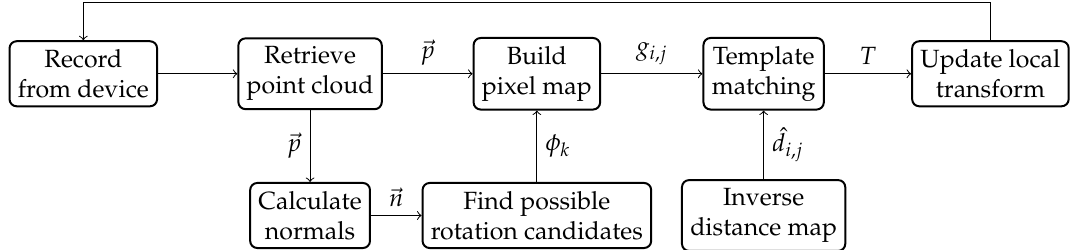
Figure 1. Algorithm overview: (cid:126) p is the processed point cloud; (cid:126) n is the calculated normals; φ k is the rotation candidates; g i , j is the grid map over the pixel indices i , j ; d i , j is the inverse distance map of the building model; and T is the final transformation matrix. The algorithm can run continuously on the device and update when new point-cloud data is